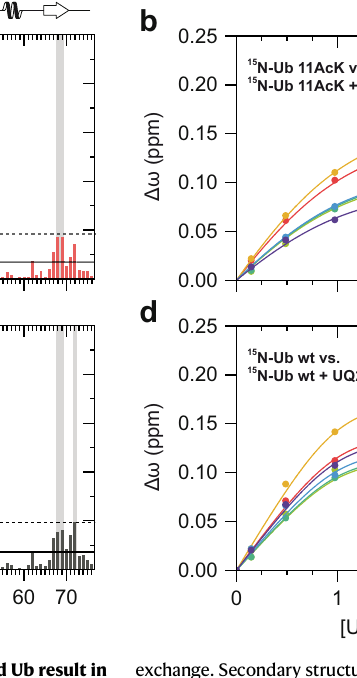
exchange. Secondary structural elements are depicted on the top of the graph according to the NMR solution structure of nonmodi fi ed Ub (PDB ID 1D3Z) 79 ; the positionof11AcKisindicatedbyanarrowin a . b , d Individualbindingisothermsare shownfortheresiduesthatwereincludedintotheglobal fi ttingprocedureinorder to determine the dissociation constant of the complex of UQ2-UBA with Ub 11AcK ( b ) and nonmodi fi ed Ub ( d ), with a concentration ofUb11AcKand Ub of c =33 µ M. The corresponding K d values are provided in the text and in Supplementary Fig. 5. Source data are provided as a Source Data fi